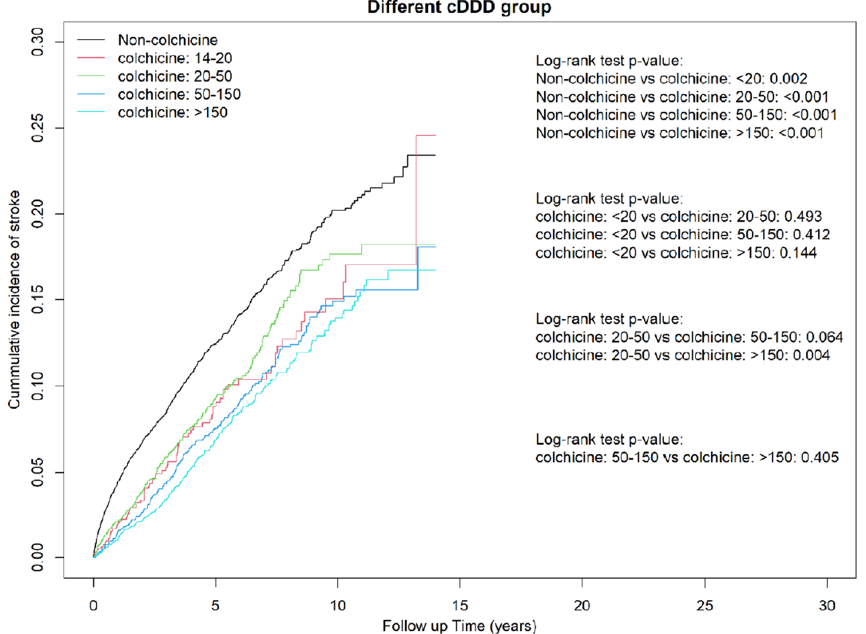
Figure 3. Cumulative incidence of stroke between different cDDD groups of colchicine users and nonusers obtained using the Kaplan–Meier method.